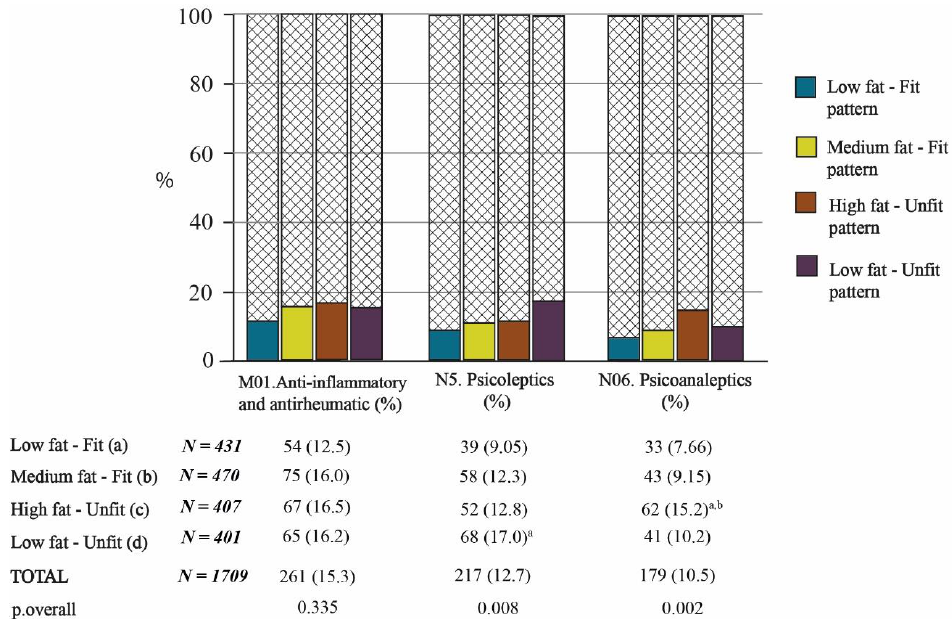
Figure 5. Consumption of drugs related to the musculoskeletal and nervous systems according to the Fat–Fit patterns. The letters in superscript indicate the bilateral comparisons that are significantly different ( p < 0.05).